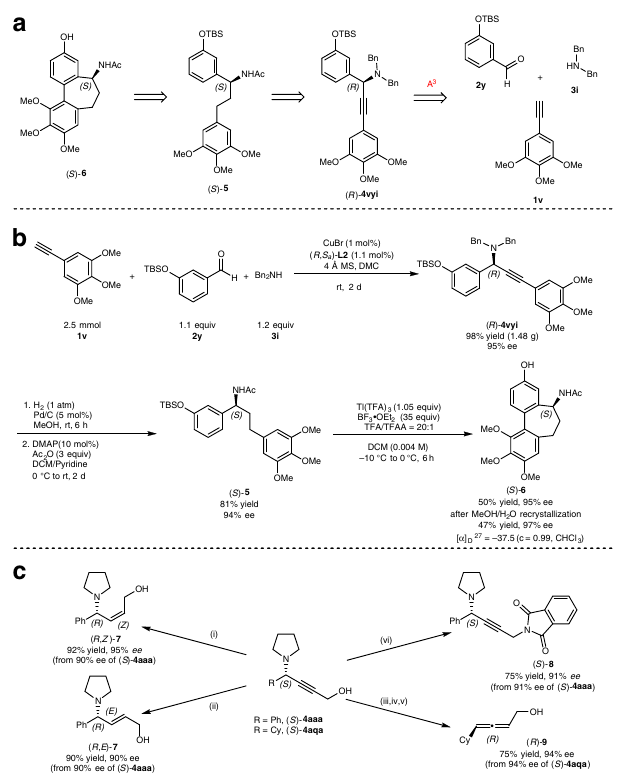
Fig. 4 Synthetic applications. a Retrosynthetic analysis of ( S )- 6 . b A catalytic enantioselective synthesis of ( S )-(-)- N -acetylcolchinol ( S )- 6 . c Transformation of propargylic amines ( S )- 4aaa and ( S )- 4aqa . Reagents and conditions: (i) Ni(OAc) 2 ·4H 2 O (1 equiv), NaBH 4 (1 equiv), ethylenediamine (3.5 equiv), EtOH, H 2 (1 atm), r.t., 3 h; (ii) LiAlH 4 (2 equiv), THF, 0 °C to r.t., 3 h; (iii) TBSCl (1.2 equiv), imidazole (2 equiv), DCM, r.t., 12 h; (iv) ZnI 2